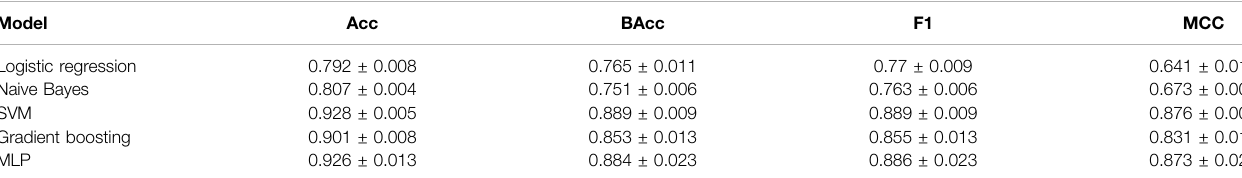
TABLE 5 | Results for the classi fi cation of complexes on basic spectral features. For each metric, the fi rst column is the average over the results 10 runs of the cross- validation, while the second column is the standard deviation of these results. Model